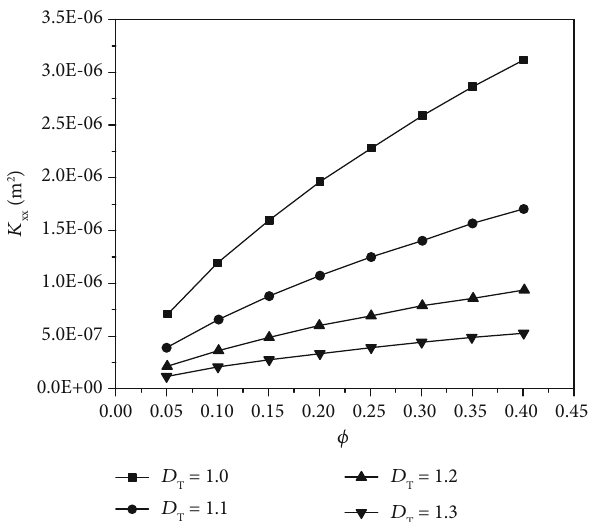
and D ( D = 1 : 1 , β = 0 : 01 , xx f T